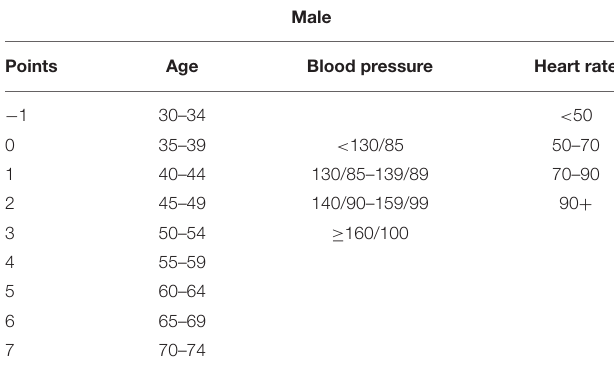
TABLE 11 | Cardiac arrest risk score for men.